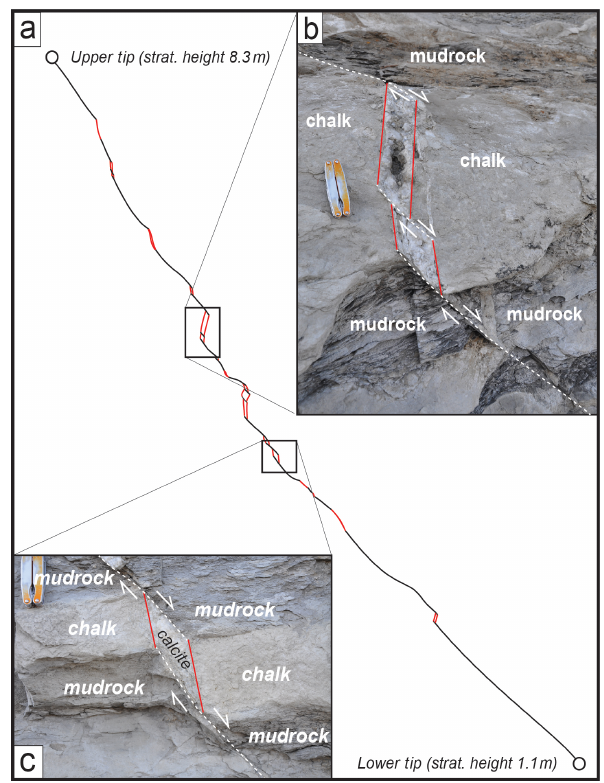
Figure 2. Details of the Textbook fault in Eagle Ford Forma- tion outcrop at Sycamore Bluffs in southwest Texas. See Ferrill et al. (2017a) for additional detail on the exposure and faults. The sec- tion is heterolithic, including primarily chalk, marl, and calcareous mudrock. Faults tend to be represented by shear failure through mu- drock and hybrid failure through chalk beds, resulting in refracted fault profiles that exhibit dilation of steep segments through chalk beds. Dilational segments are represented by mechanical aperture that is (b) partially cemented with calcite or (c) completely ce- mented with